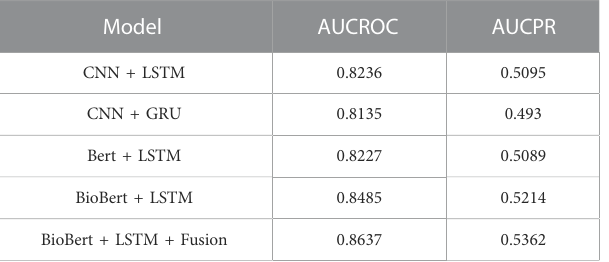
TABLE 5 Performance of each model in the 10 clinical